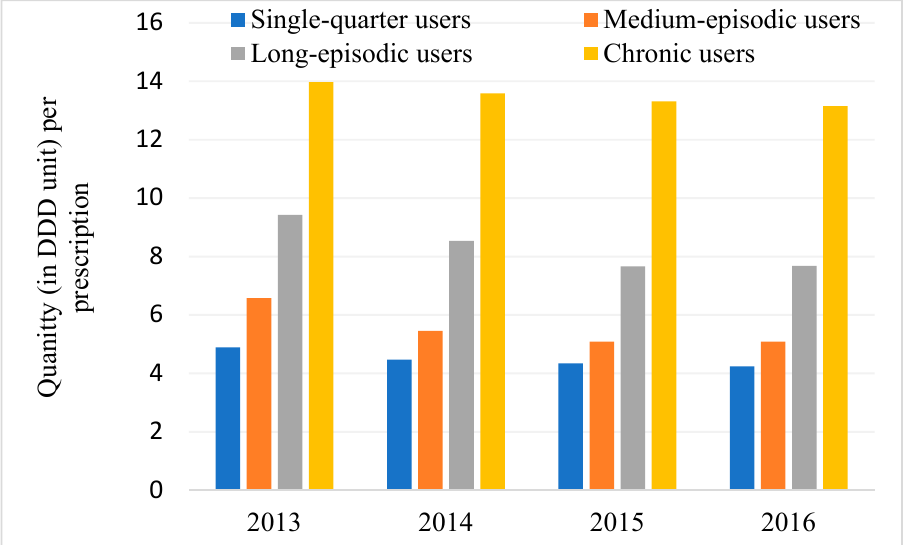
Figure 2. Year-wise trends in dispensing of opioids per prescription in DDD unit.